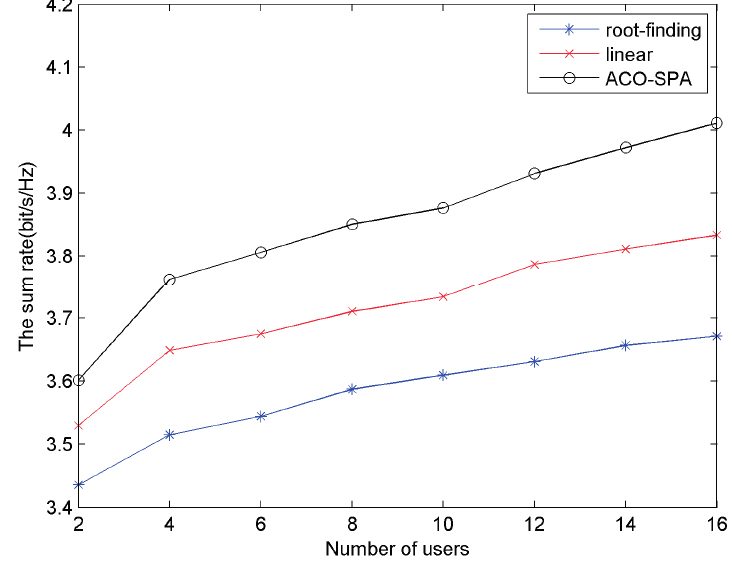
Figure 5. The sum rate versus the number of users.